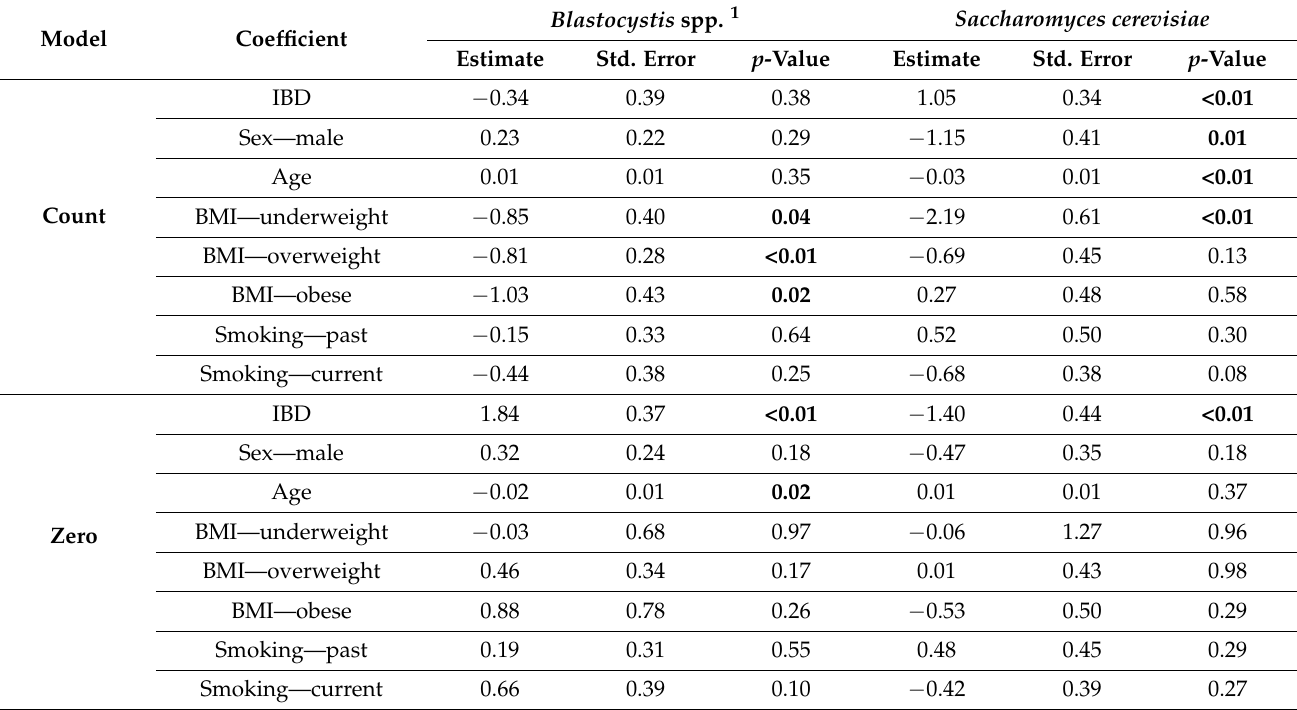
Table 2. Regression analysis